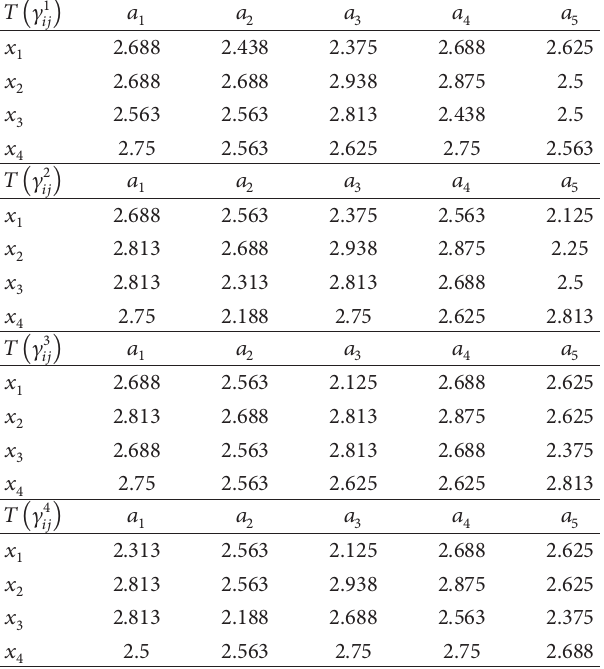
Table 2: 𝑇(𝛾 𝑘 𝑖𝑗 ) of different decision maker.